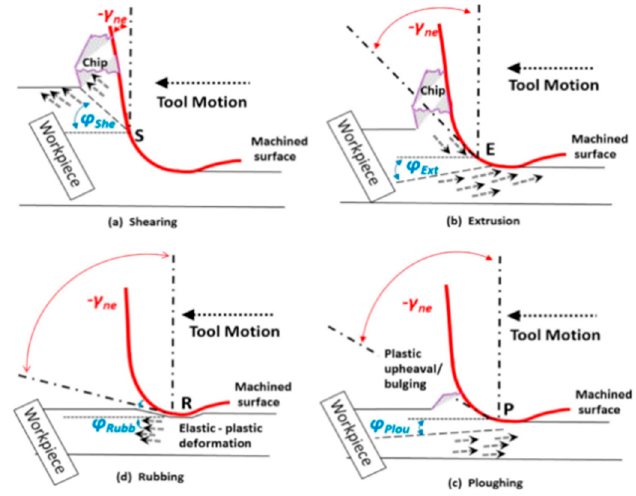
Figure 1. The four distinct chip formation mechanisms in milling [2].